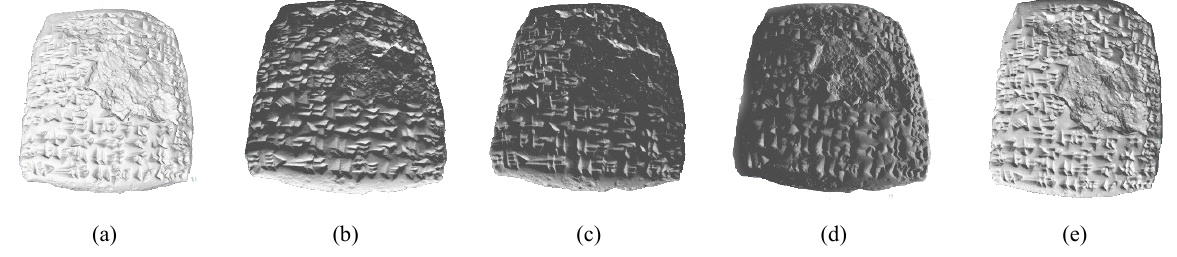
Figure 13 . 727 cuneiform tablet illuminated from different